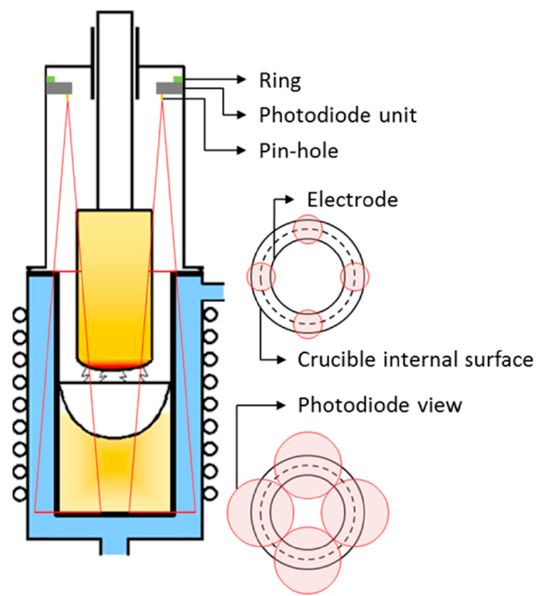
Figure 2. Schematic of the installation of the photodiode instrumentation inside a VAR furnace (Reproduced from [1], with permission from Elsevier, 2022).